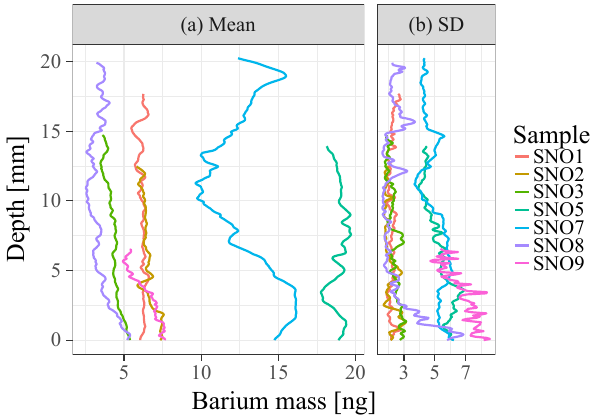
Figure 10. Vertical profiles of the Ba 2 + mass distributions of the seven intact soil samples. Arithmetic mean (a) and standard devia- tion (b) .